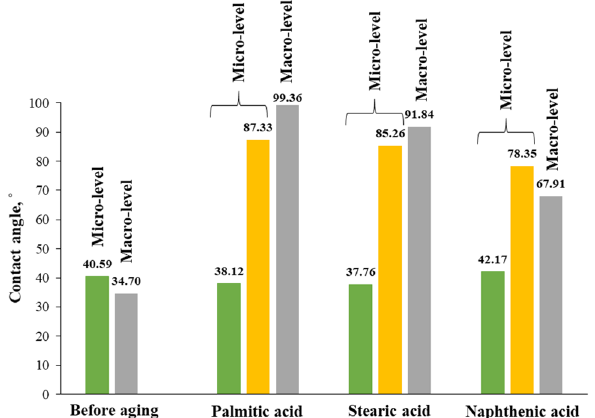
Figure 7. Comparison of contact angle data obtained at micro and macro scales before and after aging in palmitic, stearic and naphthenic